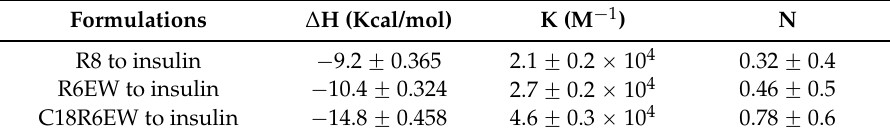
Table 1. The three fitting parameters: stoichiometry (N), enthalpy ( ∆ H) and binding constant (K).